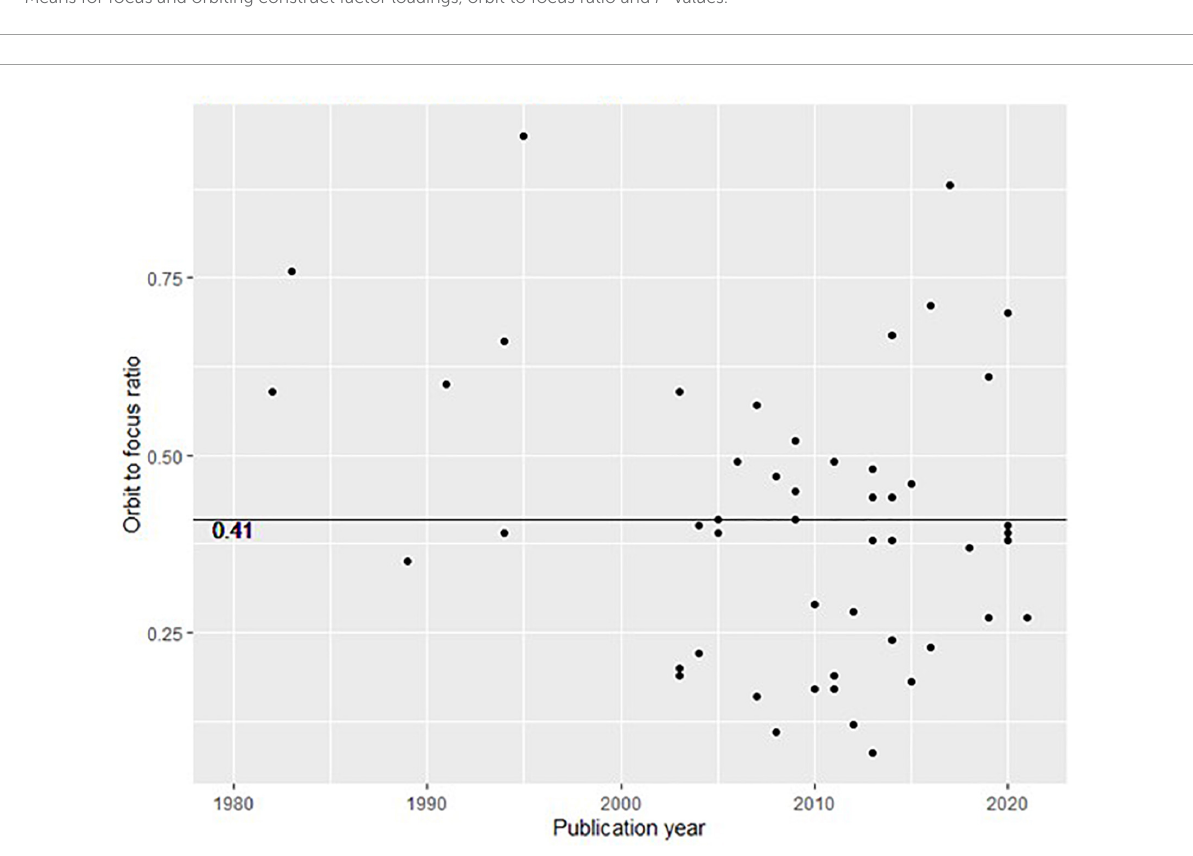
FIGURE4 Plotted ratios of orbiting to focus factors (similar to explained variance in Figure 2 ).